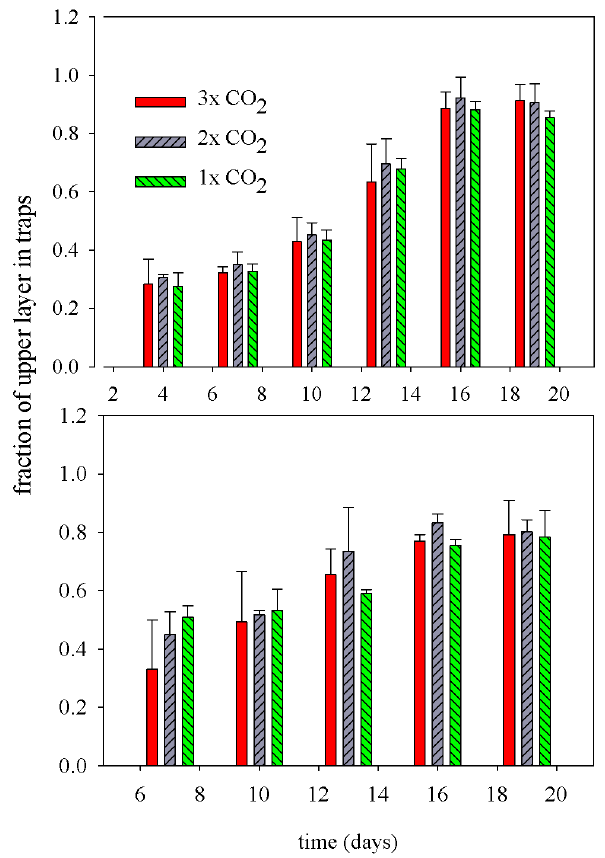
Fig. 7. The fractions in the sediment traps derived from the upper layer for (A) phytoplankton and (B) bacteria. Average and SD are shown for the triplicate